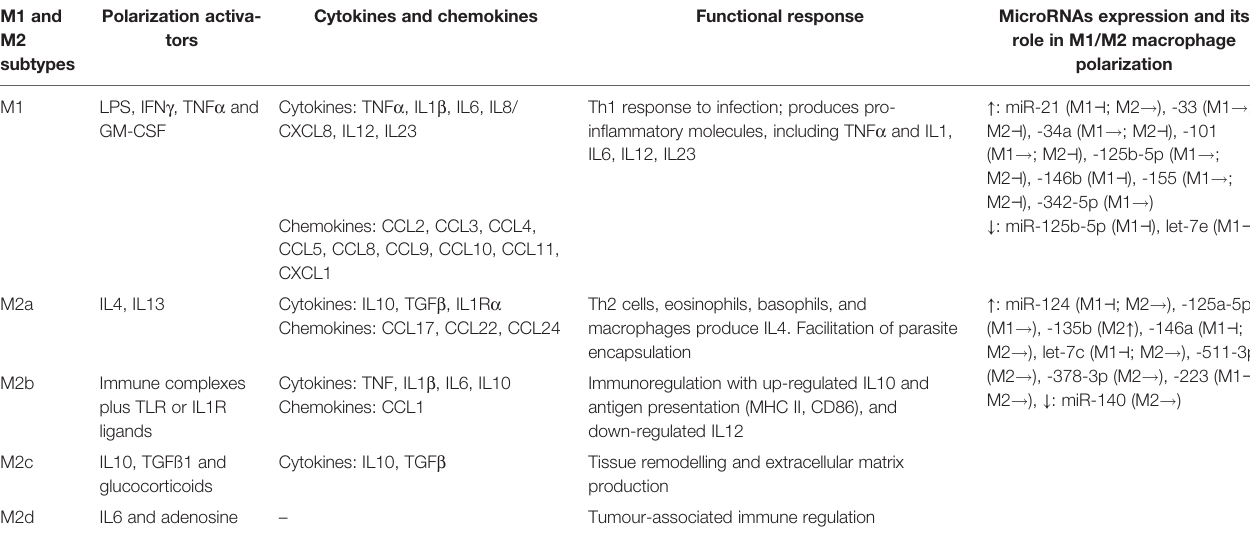
TABLE 1 | Macrophage subtypes, its activators and implication of cytokines and chemokines in functional response that is also regulated by microRNAs-mediated macrophage